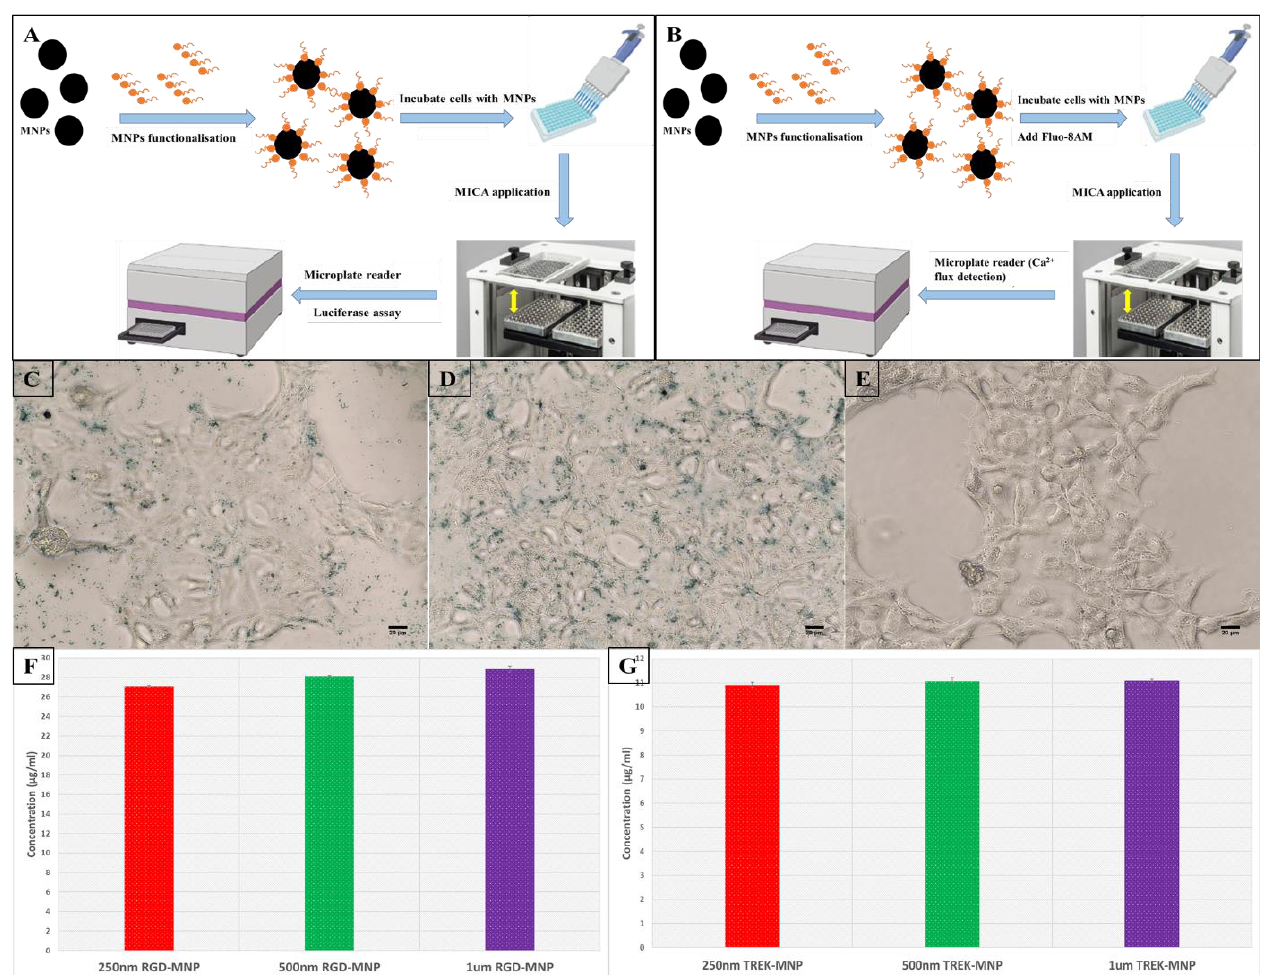
Figure 1. Graphic representation of experimental details of the application of MICA-based ( A ) Luciferase assay measurement procedure and ( B ) Fluo-8AM Ca 2+ cytosolic Ca 2+ levels’ detection procedure. Prussian blue-stained images of HEK293 cells labelled with ( C ) RGD-MNPs and ( D ) TREK1-MNPs compared to ( E ) non-labelled control cells. NanoOrange protein quantification results of ( F ) RGD-MNPs and ( G ) TREK1-MNPs.